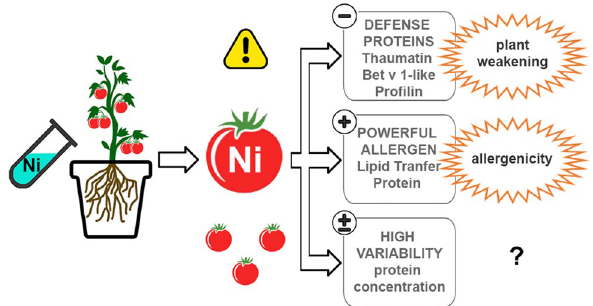
Figure 8. Schematic resume of the main results of the